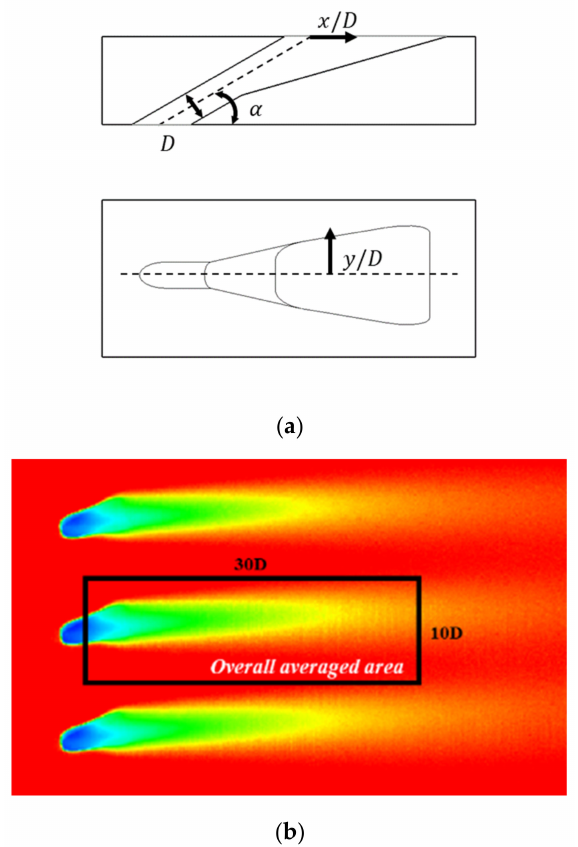
Figure 4. Definition of coordinate and overall averaged area of the compound angled asymmetric fan shaped hole: ( a ) definition of coordinate; ( b ) overall averaged